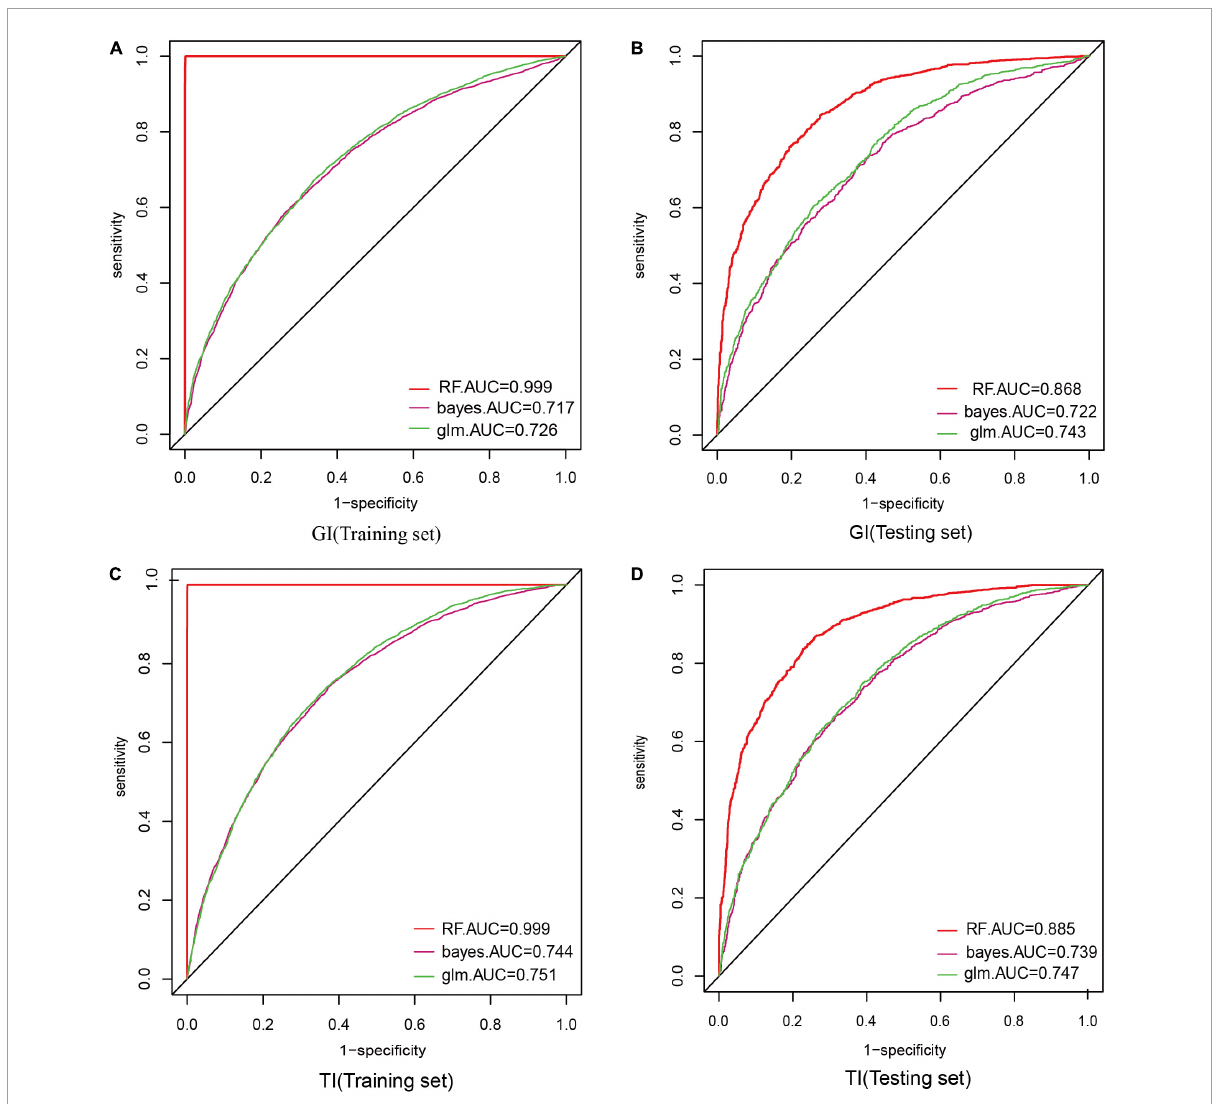
FIGURE4 Comparison of the ROC curve areas of the three model classifiers. In model construction, 70% of samples were randomly divided as training set, and the rest 30% were as testing set. AUC (area under curve) was used to evaluate the performance of these three classifiers. (A) AUC of GI in the training set; (B) AUC of GI in the testing set; (C) AUC of TI in the training set; (D) AUC of TI in the testing set.